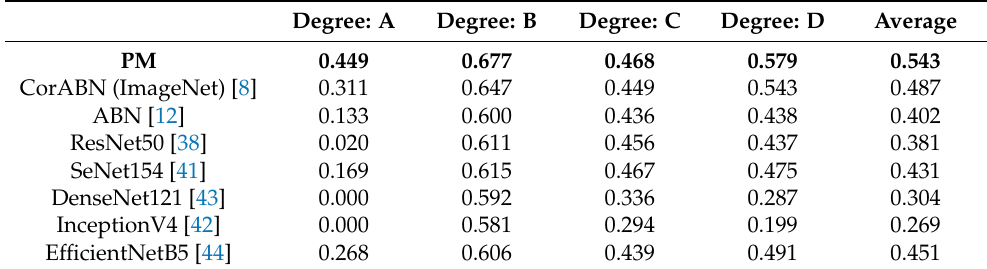
Table 8. F1-scores of PM and CMs in the distress type of rebar corrosion. The best scores for each degree and the average are presented in bold.